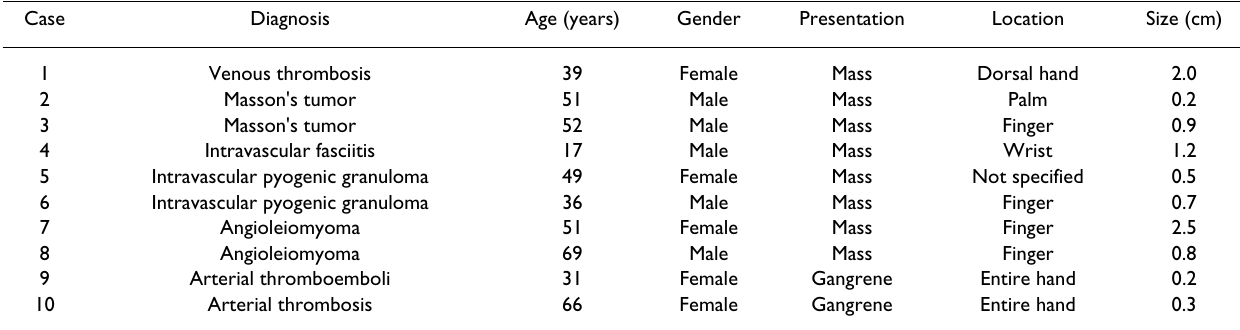
Table 1: Patient clinicopathologic